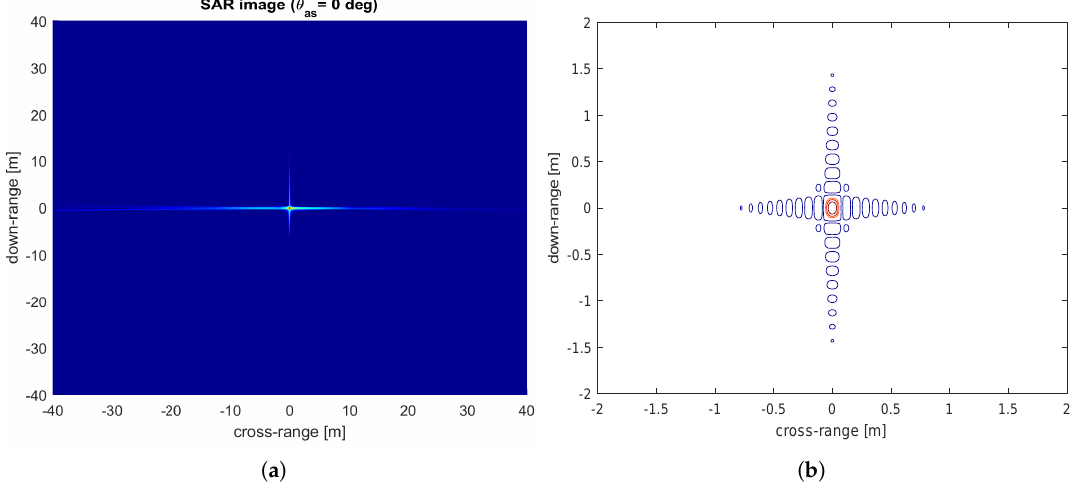
Figure 15. SAR image: ( a ) two-dimensional plot; ( b ) contour plot